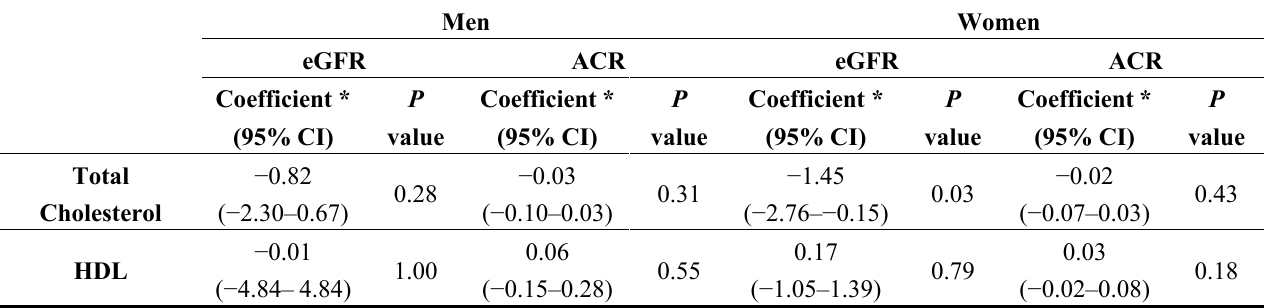
Table 3. Correlation of estimated glomerular filtration rate (eGFR) and urinary albumin to creatinine ratio (ACR) with lipid profiles in male and female